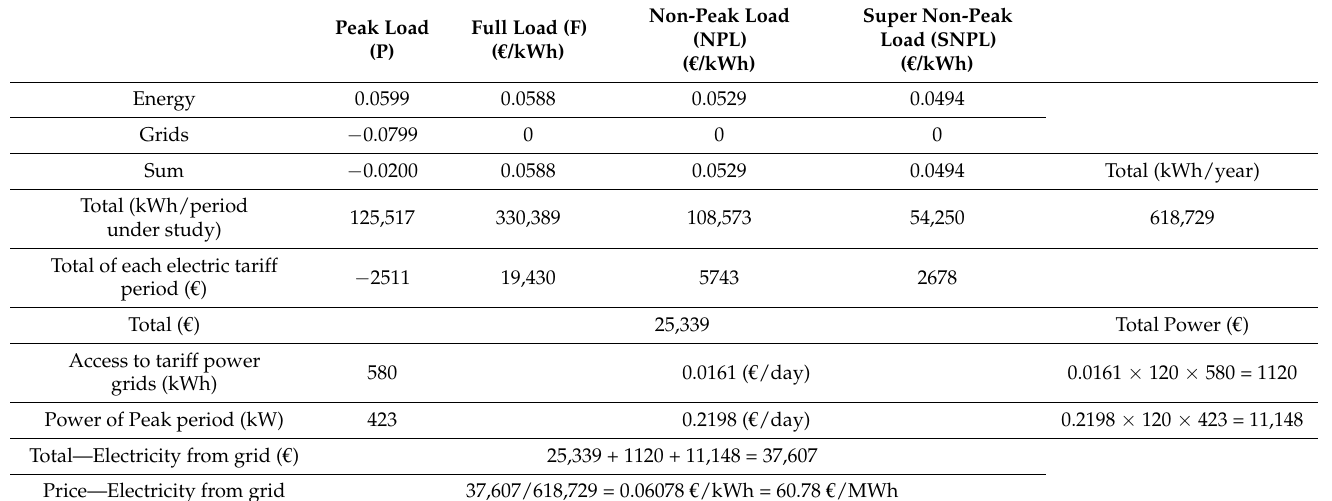
Table 18. Calculation of the average price of electricity from the wind turbine manufacturing network using an invoice for the year